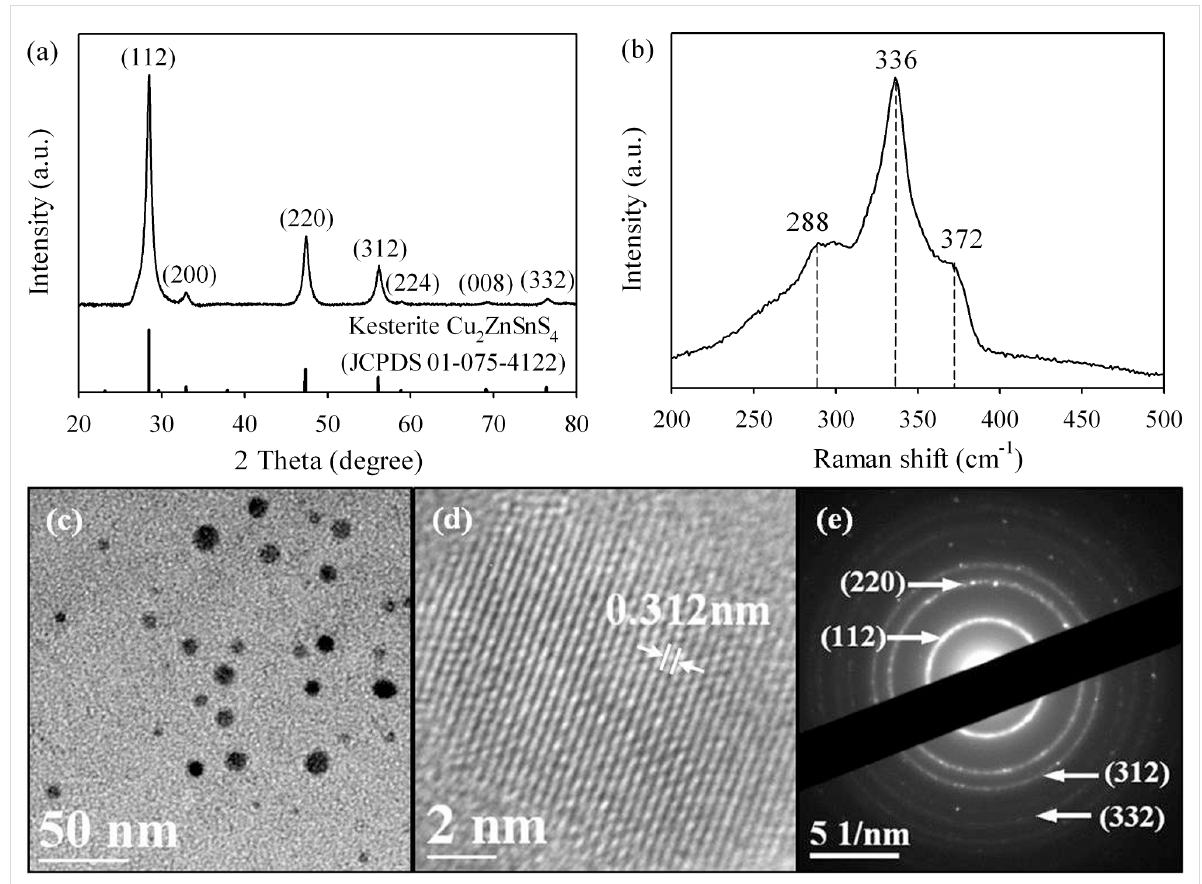
Figure 1: (a) XRD patterns, (b) Raman spectra, (c) TEM image, (d) HRTEM image and (e) SAED pattern of CZTS nanocrystals hydrothermally synthesized at 240 °C for 24